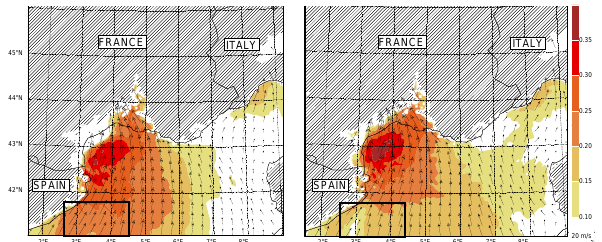
Fig. 6. Water vapour flux (in kg s − 1 , colour scale on the right of the figure) and wind vector at 100ma.s.l. at 03:00UTC, 12 August 2008, for both the HRA2.5 simulation (left panel) and the RAI2.5 one (right panel). Wind arrows are drawn every 10 grid points with a scale in ms − 1 given by the length of the arrow at the bottom right of the figure. The black rectangle delimits the moist feeding flow area. Model terrain higher than 100ma.s.l. is hatched.